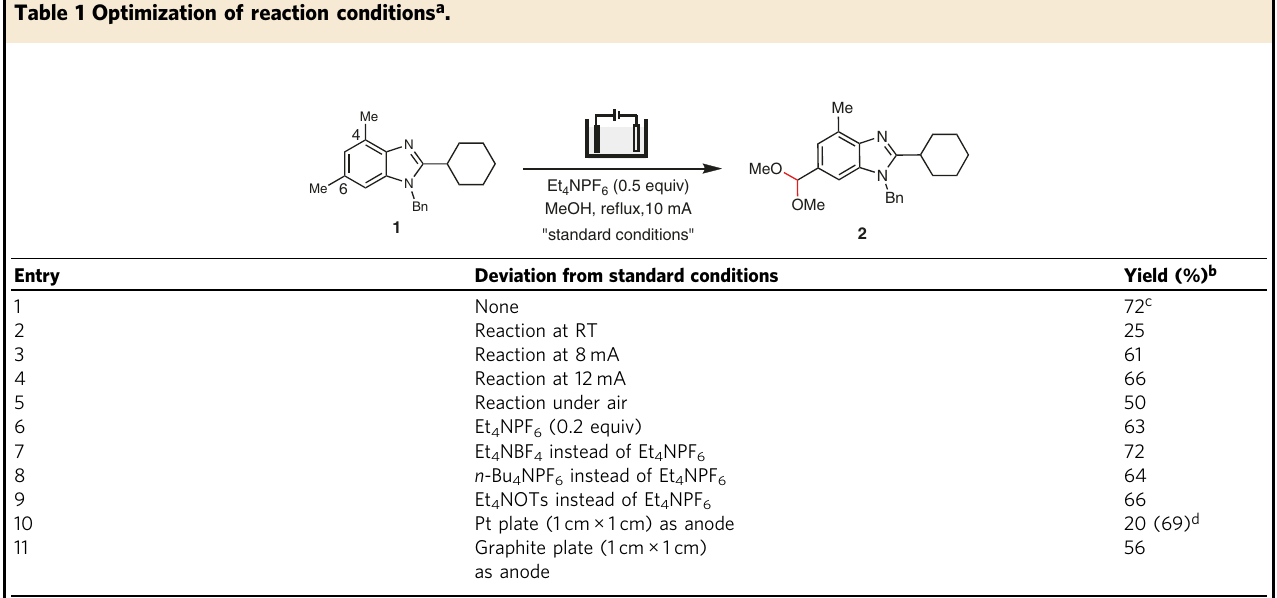
Table 1 Optimization of reaction conditions a .